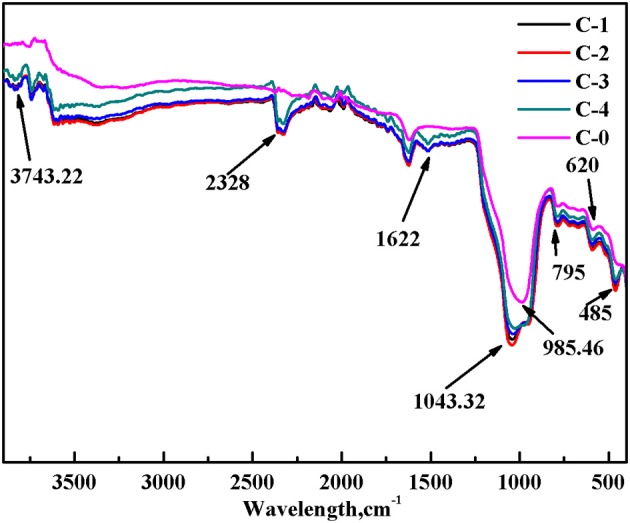
FT-IR spectra of modified clinoptilolites.